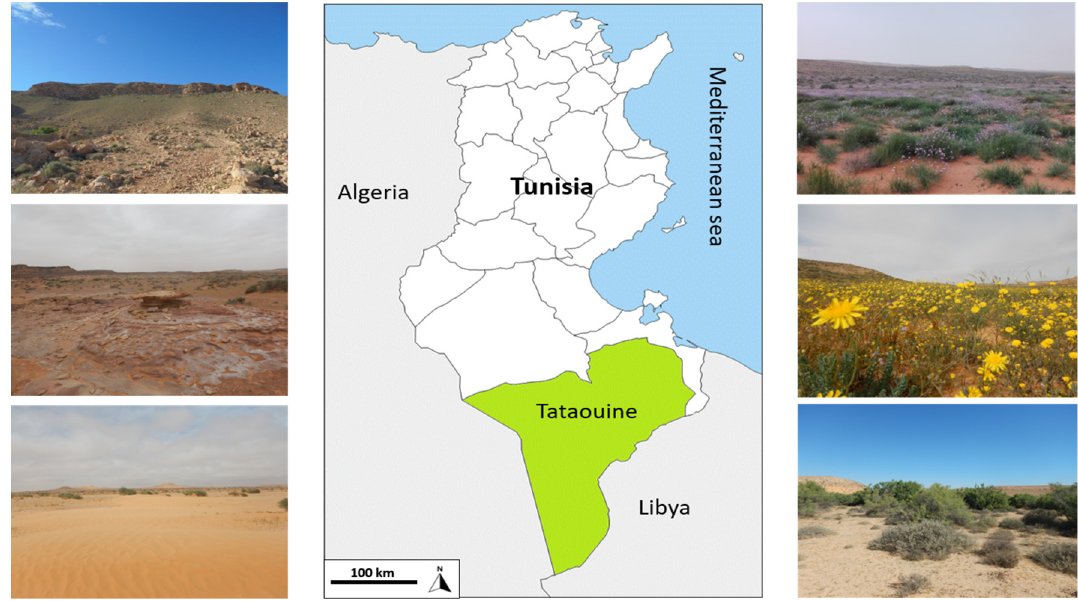
Figure 1. Map of the governorate of Tataouine and its location in Tunisia; pictures taken during spring 2018 showing the different natural habitats exploding with flowers in a rare phenomenon.